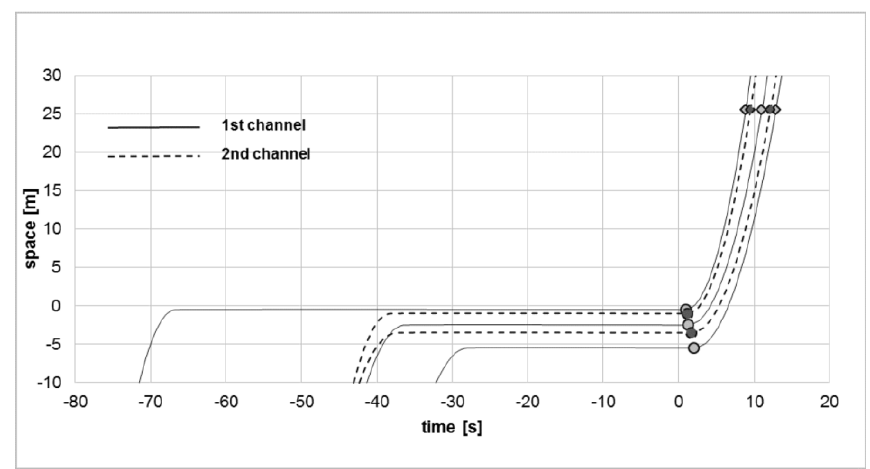
Figure 14. Space-time diagram for cyclists in the Q(5,2) multichannel queue